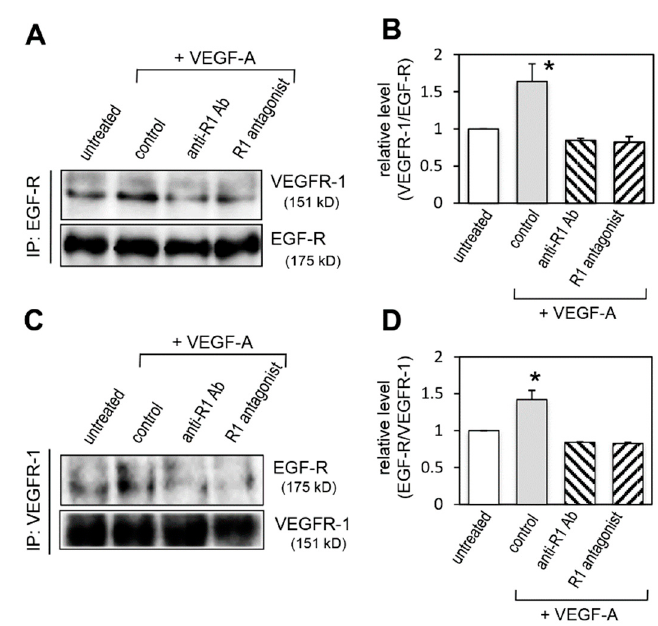
Figure 9. VEGFR-1 blockade decreases complex formation of VEGFR-1 and EGF-R. Cells were untreated or pretreated with anti-R1 Ab, R1 antagonist or control IgG (control) for 3 min, and then stimulated with VEGF-A for 2 min. ( A ) Cell lysates were immunoprecipitated with an anti-EGF-R antibody (IP: EGF-R) and then immunoblotted for VEGFR-1 ( A , upper panel). In parallel, Western blot was performed to control for EGF-R concentration in the immunoprecipitates ( A , lower panel). ( B ) Quantification of co-immunoprecipitated VEGFR-1 levels normalized to immunoprecipitated EGF-R from three independent experiments. * p < 0.01, statistically significant increase compared with the untreated cells. ( C ) Cell lysates were immunoprecipitated with an anti-VEGFR-1 antibody (IP: VEGFR-1) and then immunoblotted for EGF-R ( C , upper panel). In parallel, Western blot was performed to control for VEGFR-1 concentration in the immunoprecipitates ( C , lower panel). ( D ) Quantification of co-immunoprecipitated EGF-R levels normalized to immunoprecipitated VEGFR-1 from three independent experiments. * p < 0.01, statistically significant increase compared with the untreated cells.